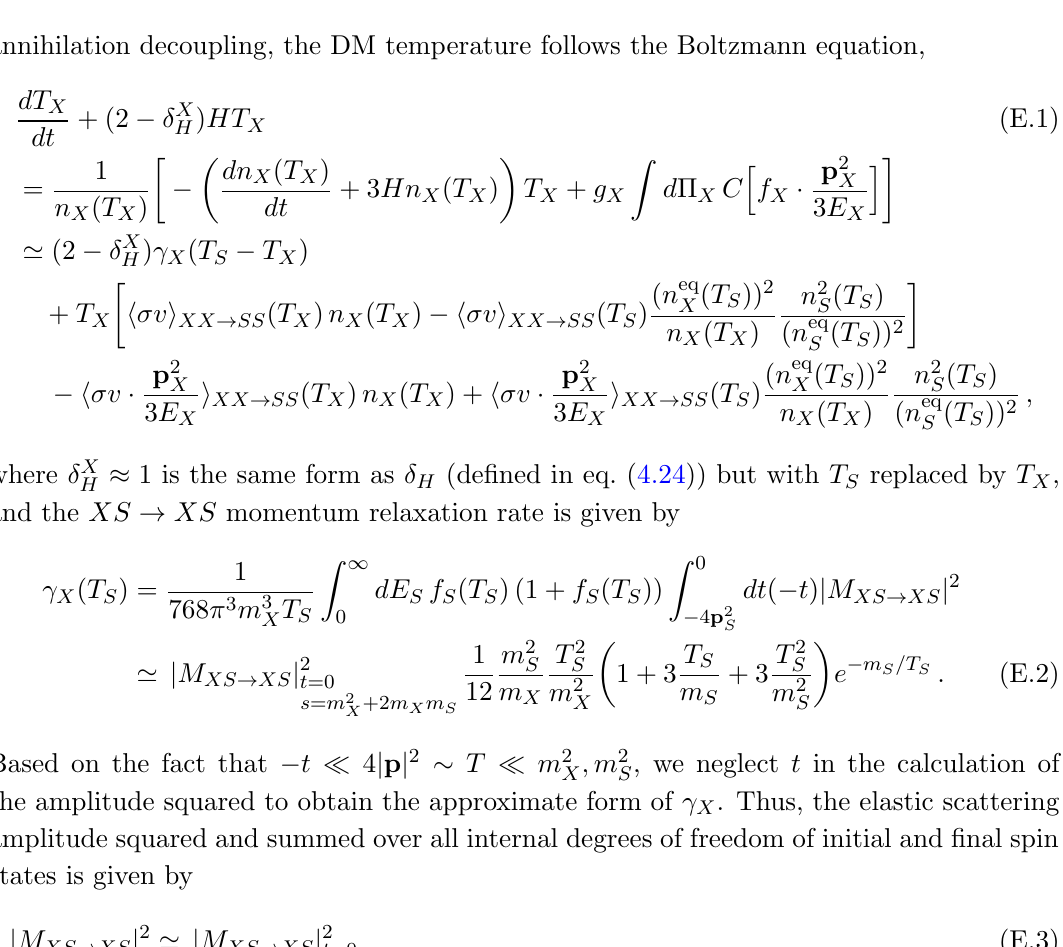
Figure 15 . Feynman diagrams for the annihilation SSS ! SS